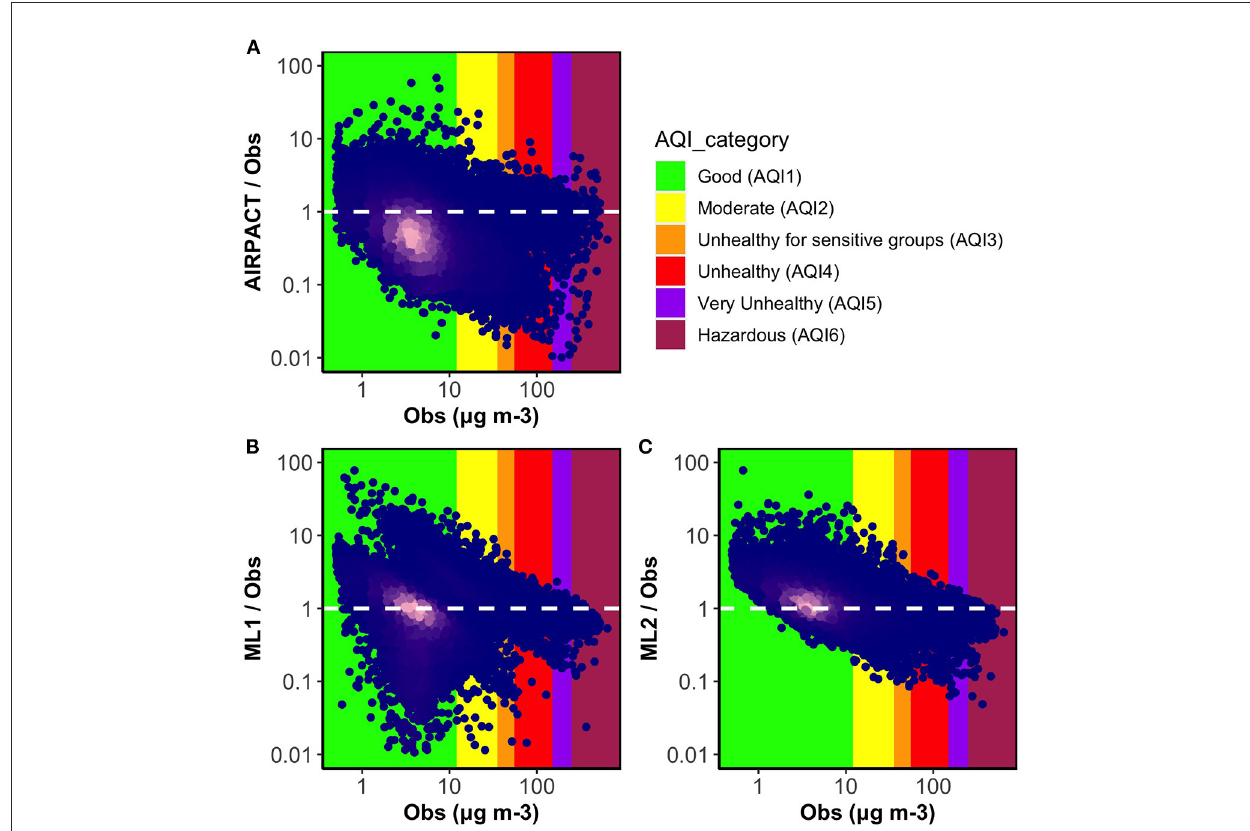
FIGURE6 Ratio plots of model predicted daily PM2.5 to observations vs. observations in the wildfire season for three models (A) AIRPACT, (B) ML1, and (C) ML2. The point color of dark blue to bright pink indicates density of the data increasing. The white dashed lines mark the ideal condition (the ratio between model predictions and observations is 1). The ratio below 1 represents the model under-prediction and the ratio above 1 represents the over-prediction.